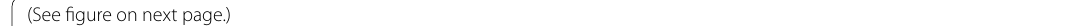
Fig. 2 LINC00240 promotes function of trophoblasts and M2 macrophage polarization in preeclampsia model in vitro. A qPCR measurement on LINC00240 levels in two human trophoblasts (HTR‑8/SVneo and JEG‑3) cultured in a normal or hypoxic condition. B qPCR measurement on LINC00240 levels in trophoblasts under a normal or hypoxic condition with/without LINC00240 overexpression. C CCK‑8 measurement on cell proliferation in indicated groups. D Colony formation assay on cell proliferation in indicated groups. E Wound healing assay on cell migration in indicated groups. F Flow cytometry analysis of M2 polarization markers (Arg‑1, CD68) in macrophages co‑cultured with trophoblasts after indicated treatments. G qPCR measurement on M2 marker (Arg‑1) mRNA levels in macrophages co‑cultured with trophoblasts after indicated treatments. H qPCR measurement on M1 marker (iNOS) mRNA levels in macrophages co‑cultured with trophoblasts after indicated treatments. All the experiments were repeated at least three times. * P < 0.05, ** P < 0.01 and *** P <